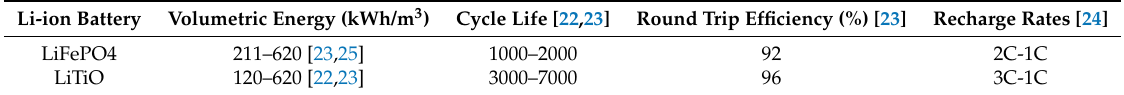
Table 1. Parameters of Li-ion batteries.